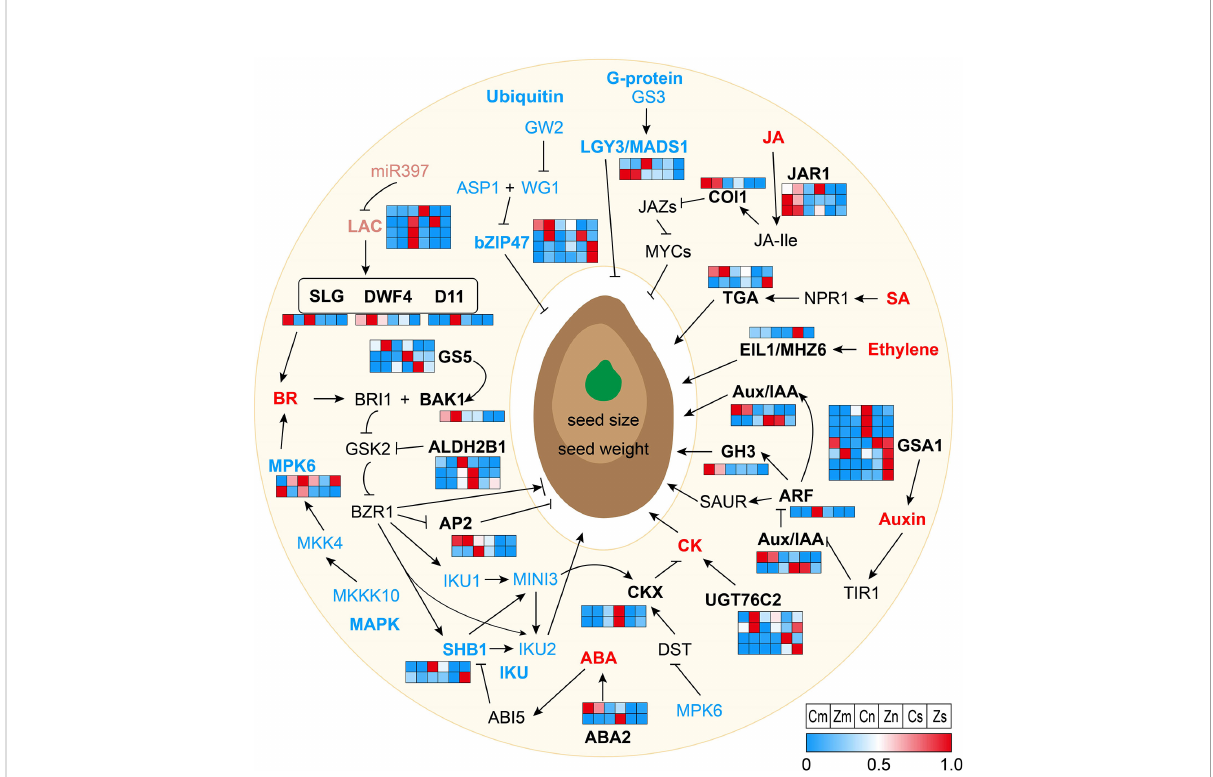
FIGURE 3 Regulation network via multiple signaling pathways for seed size and weight. Normal arrows represent activated or positive regulation, and block arrows indicate inhibition or negative regulation. Different color letters show proteins that are involved in different signaling pathways. Black letters represent the phytohormone pathways; blue letters represent the G-protein, ubiquitin – proteasome, mitogen-activated protein kinase (MAPK), and IKU pathways, and pink letters represent the microRNA regulators. Red letters indicate the phytohormones. Black, blue, and pink bold letters in the pathways represent the differentially expressed genes (DEGs) identi fi ed in this study. Heatmaps of DEGs participating in signaling pathways are displayed based on the normalized FPKM values. FPKM, fragments per kilobase of exon model per million mapped